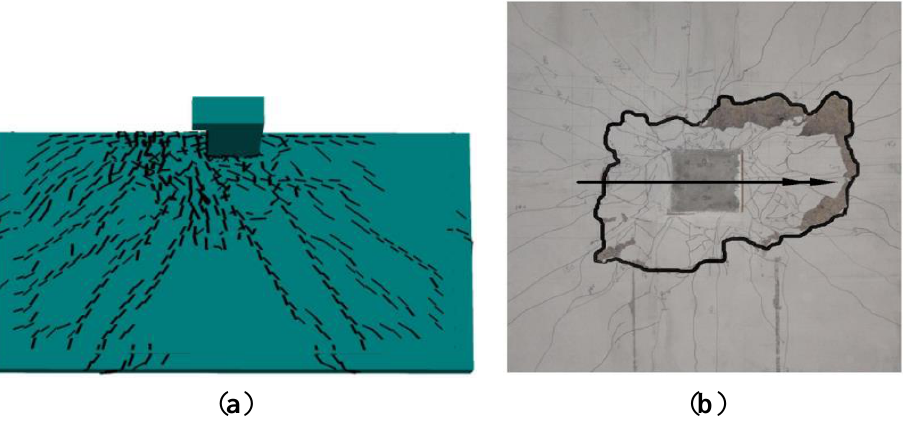
Figure 8. Cracking pattern for the model with a 0.65% reinforcement ratio. ( a ) FEM; ( b )